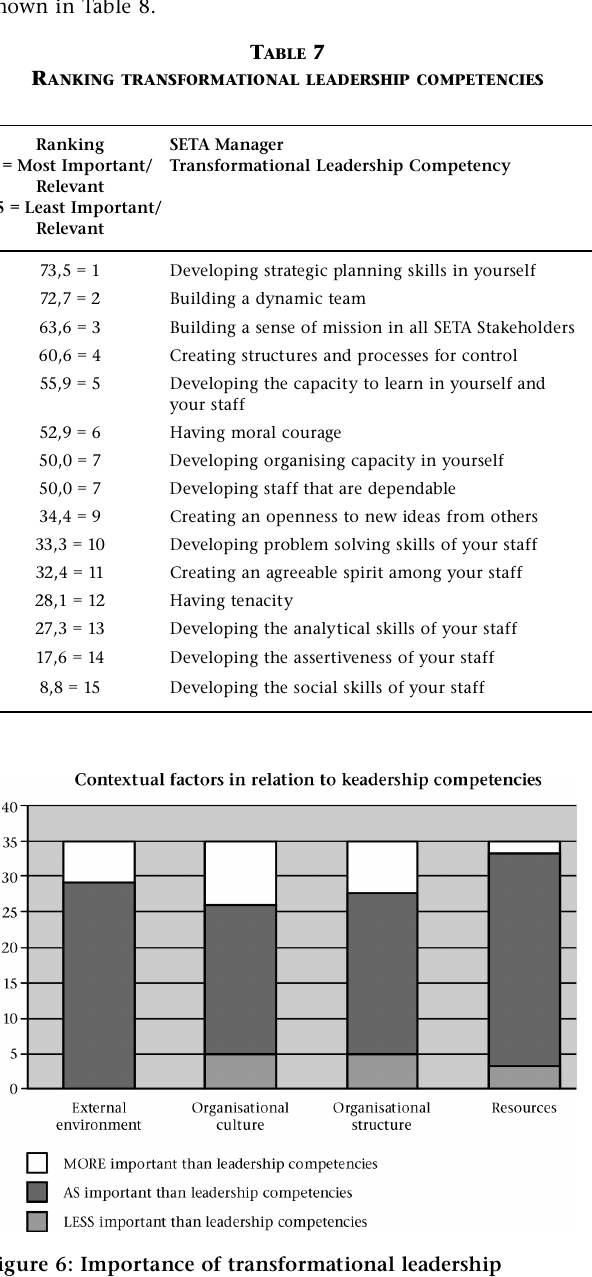
Figure 6: Importance of transformational leadership competencies in relation to other organisational contextual factors from responses of SETA